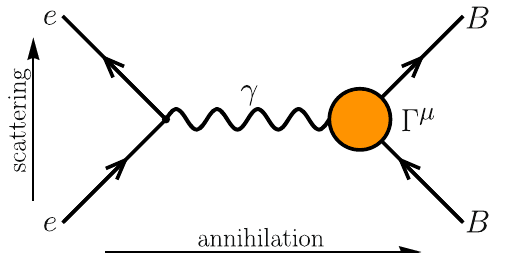
Fig. 1 Feynman diagram for the scattering eB → eB and the anni- hilations e + e − ↔ B ¯ B , in Born approximation. The non-constant (cid:7) μ matrix is associated to the vertex BB